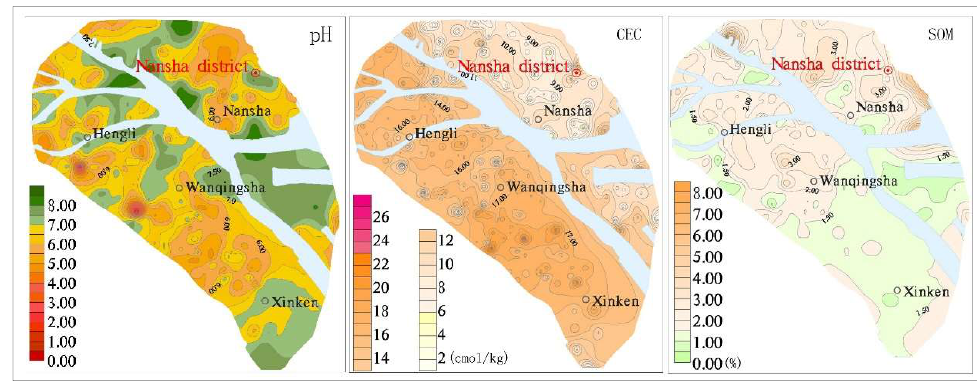
Figure 4. Contour map of pH, cation exchange capacity (CEC), and soil organic matter (SOM). Table 3. Descriptive statistics of pH, cation exchange capacity (CEC), and soil organic matter (SOM) in different soil types (n = 348).